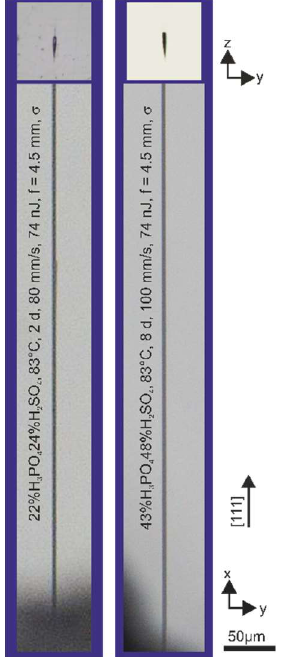
Fig. 2. Light microscope images of selectively etched channels. Writing direction and etching parameters are denoted in the